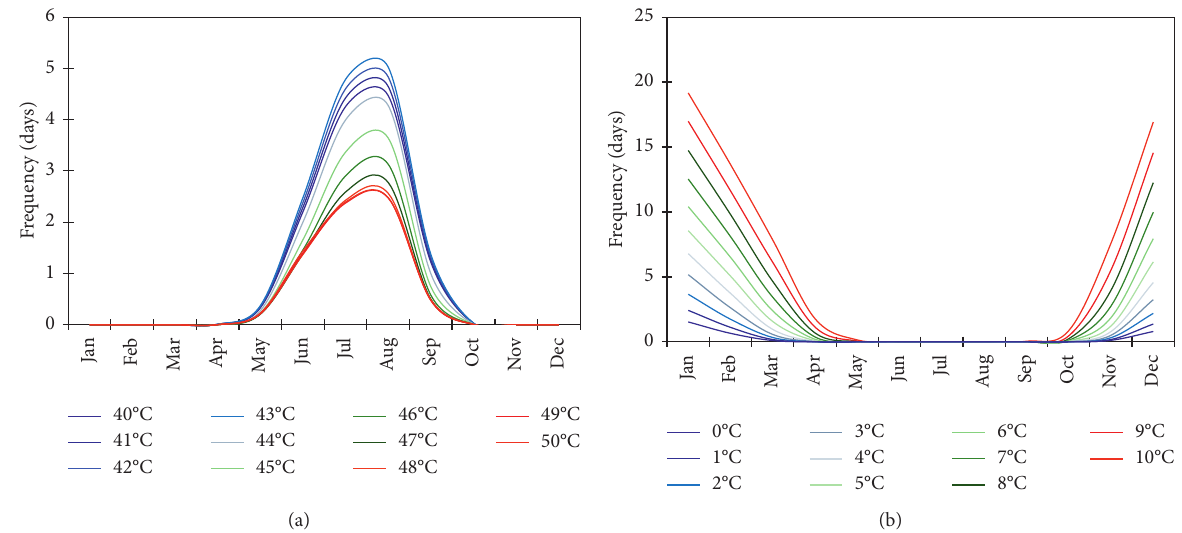
Figure 8: The annual cycle of temperature frequency for (a) TX and (b) TN at different thresholds averaged over 25 stations in Saudi Arabia for the period 1978–2019. The thresholds for TX are ≥ 40 ° C to ≥ 50 ° C with an increment of 1 ° C interval, while for TN, they are ≤ 10 ° C to ≤ 0 ° C with a decrement of 1 ° C interval. The vertical axis (frequency) scales for both panels are not the